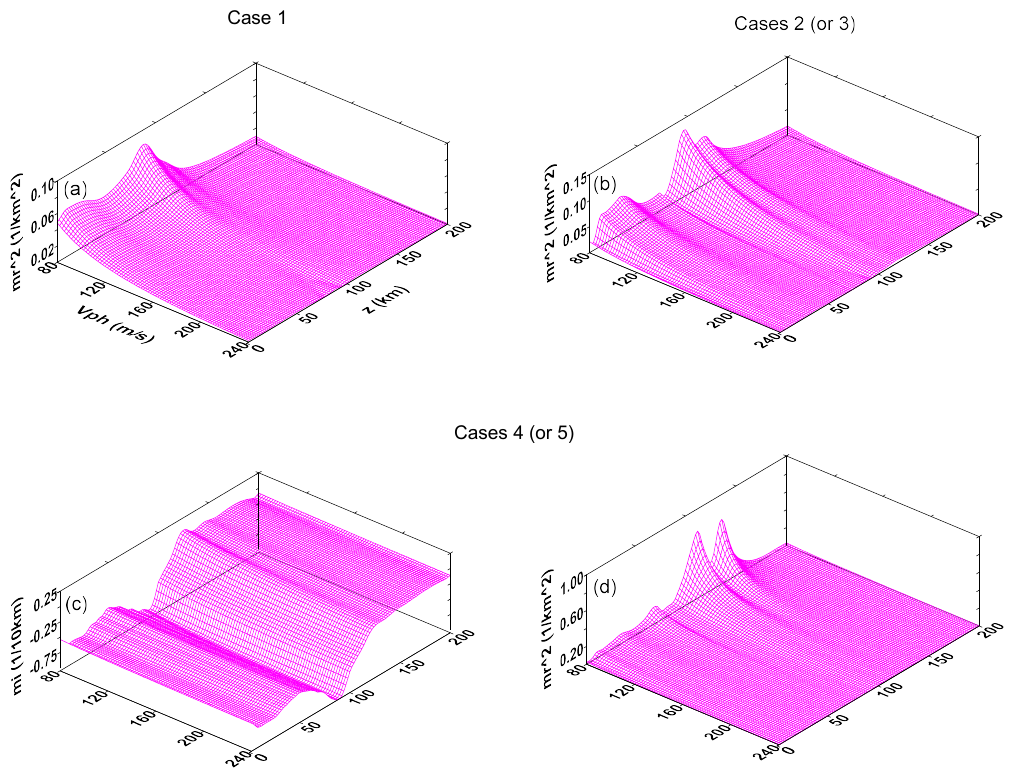
Figure 7. Dependence of m i and m 2 r on phase speed V ph at a characteristic wave period of T ts = 33.3 min. ( a ) m 2 r in Case 1; ( b ) m 2 r in Case 2 (or 3); ( c ) m i in Case 4 (or 5); and ( d ) m 2 r in Case 4 (or